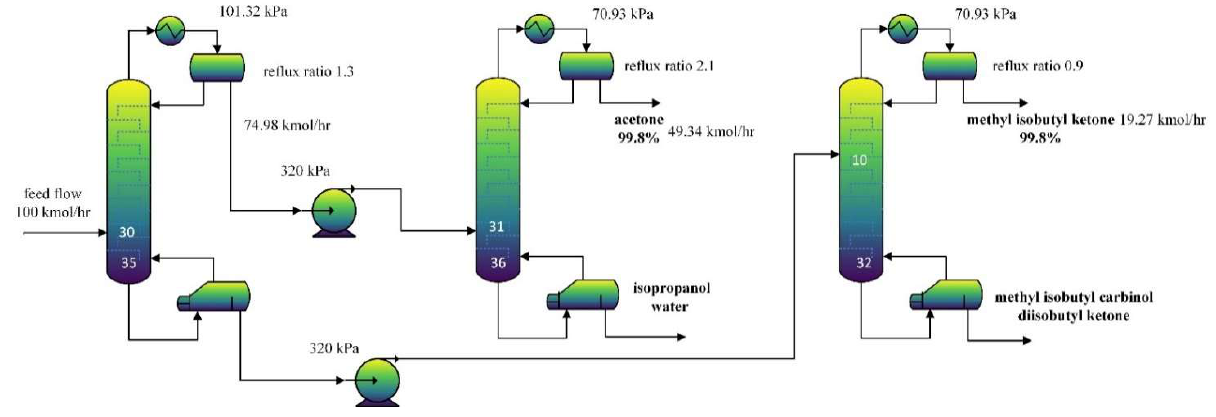
Figure 10. Flowsheet of 6-component mixture separation.